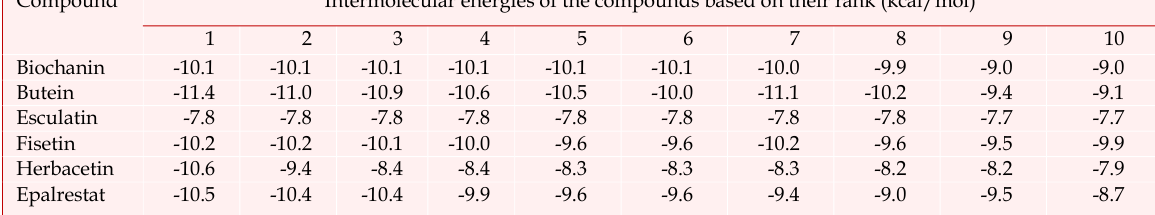
Intermolecular energies of the compounds based on their rank (kcal/mol)